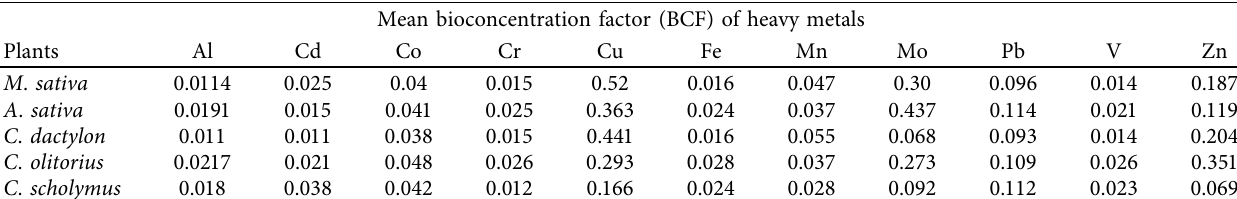
Figure 2: (a) Mean heavy metal content of M . sativa from the three sites. (b) Mean heavy metal content of M . sativa from the three sites. Table 4: Mean bioconcentration factor (BCF) values of heavy metals.